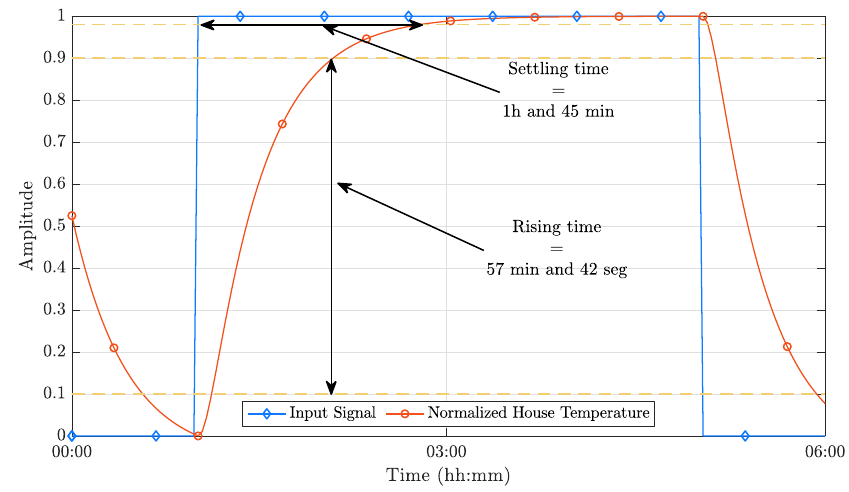
Figure 5. Step response of the dynamic